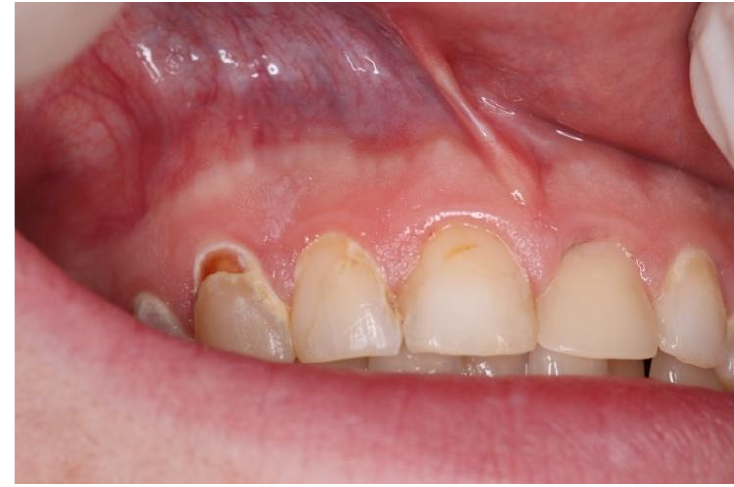
Figure 2. White, round lesion above tooth nr. 13 and nr. 12.